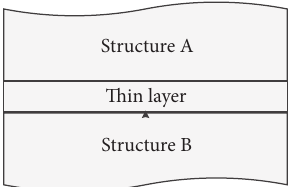
Figure 2: The sketch of the thin layer of elastic-plastic material.